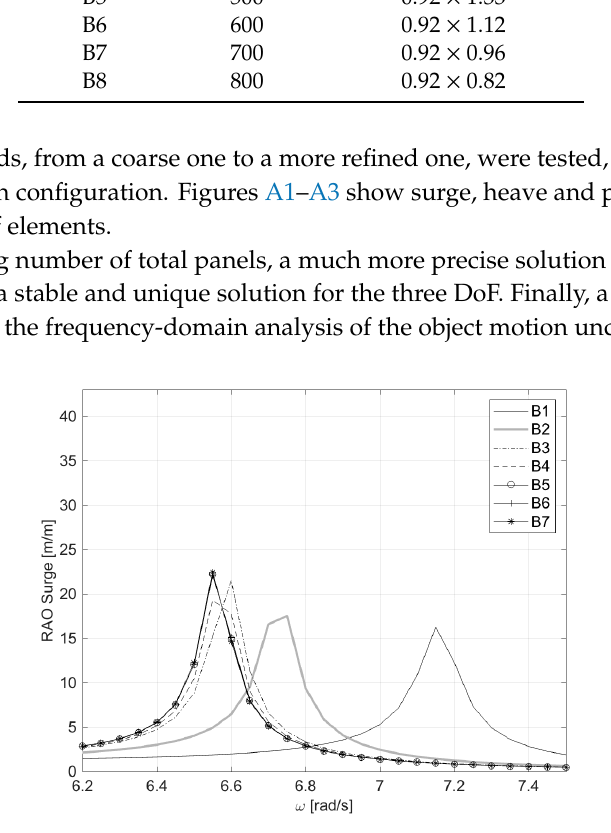
Figure A1. Comparison of surge RAO for sensitivity analysis.